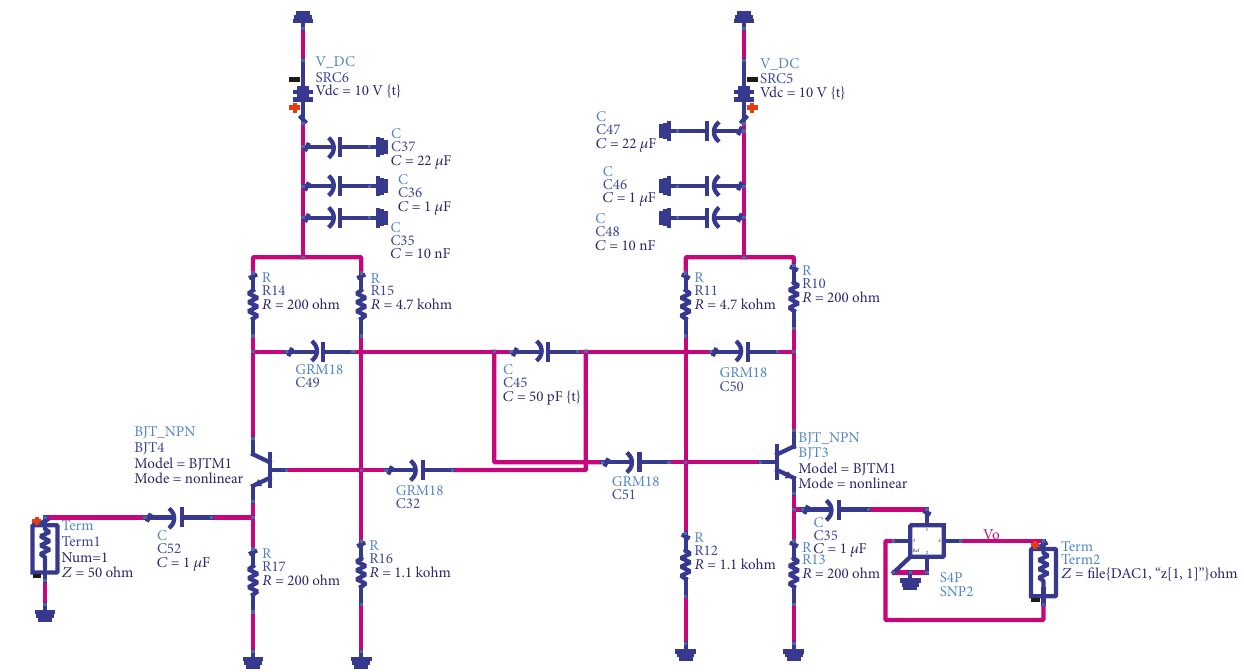
Figure 3: The schematic of the transistor-based NIC with DC bias network and coupling capacitors, in which the impedance of the dipole is imported in Term2 and the S-parameters of the balun are imported in the S4P component.